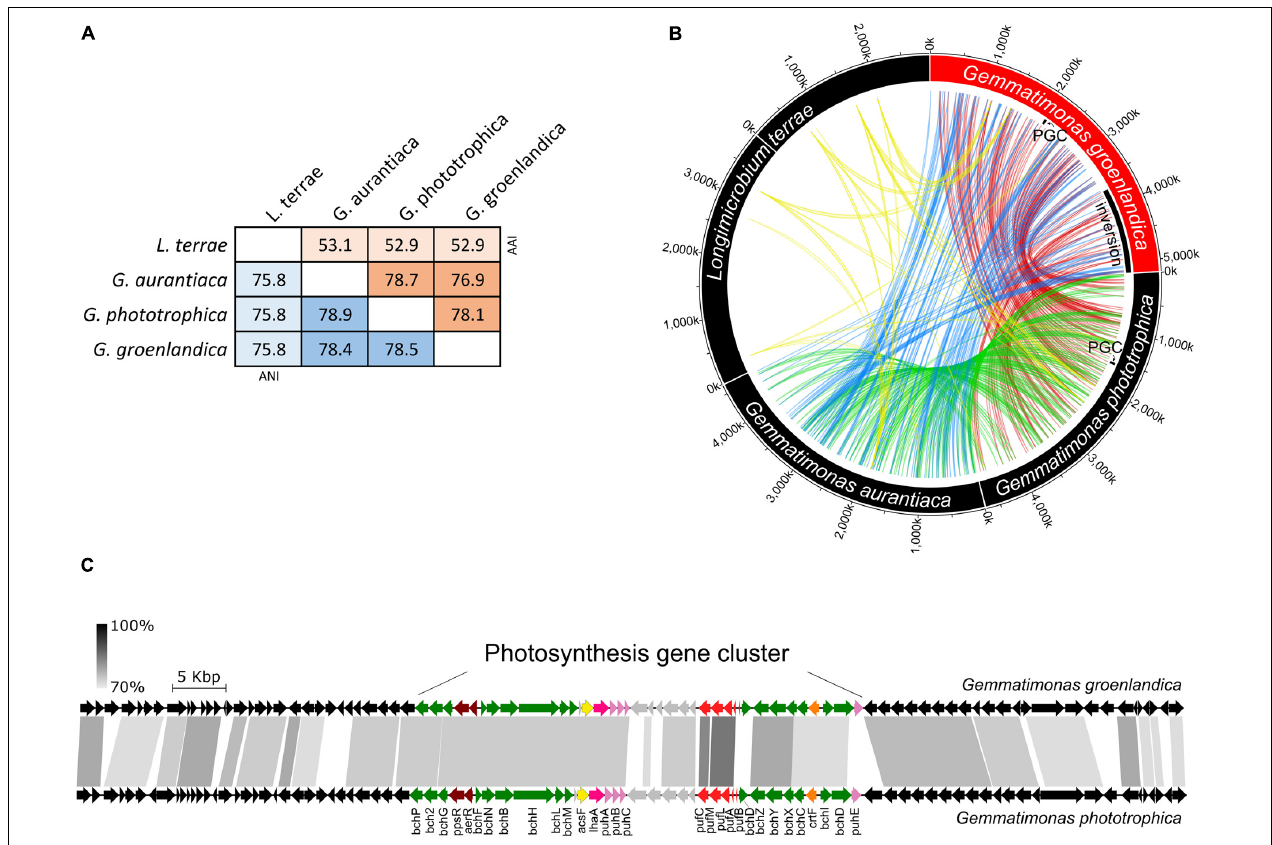
FIGURE 4 | Genome-level sequence similarity between Gemmatimonas groenlandica TET16 T and the other three type strains in the phylum Gemmatimonadetes including Gemmatimonas (G.) phototrophica AP64 T , G. aurantiaca T-27 T , Longimicrobium (L.) terrae CB-286315 T . (A) , average nucleotide identities (ANI) and average amino acid identities (AAI). (B) , genome similarity assessed by connecting highly conserved regions ( > 80% identity, > 2 kb) between each pair. Note that the L. terrae genome contains two chromosomes. Any plasmid that may exist was excluded from the analysis. The loci of photosynthesis gene clusters (PGCs) in G. groenlandica and G. phototrophica are marked. An inversion event of a large genomic region in G. groenlandica was identified and marked. (C) , Conserved genome synteny of the PGCs ( ∼ 42 kb) and neighboring regions ( ∼ 30 kb in each side; see details in Supplementary Figure 1 ) in G. groenlandica and G. phototrophica . Connecting gray blocks represent matched regions by BLASTn analysis with the cutoffs of > 70% sequence identity and > 500 bp in